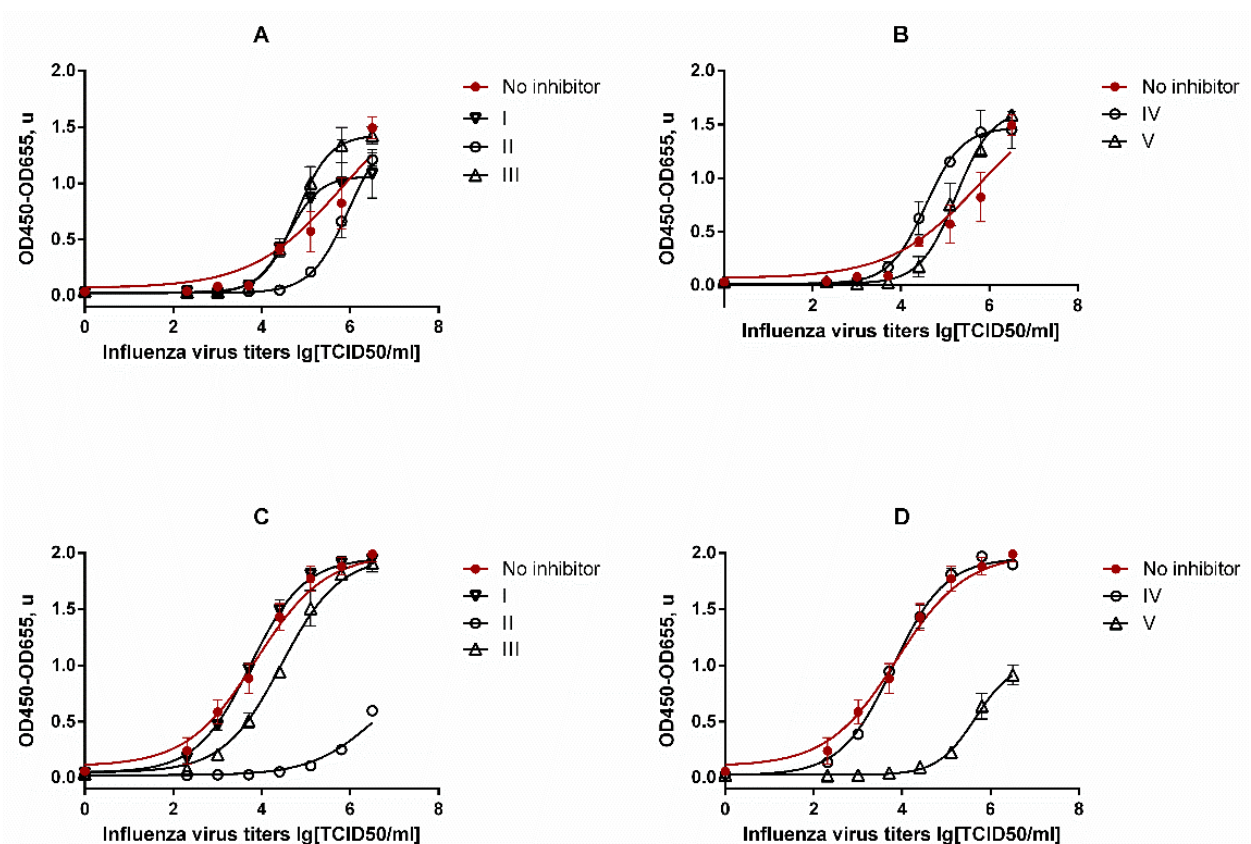
Figure 3. The assessment of the investigated compounds’ antiviral activity by ELISA. ( A , B ) the content of virions in supernatants obtained from cells upon stimulation with compounds II , III , and V ( A ) and IV , I ( B ). ( C , D ) The viral NP protein content inside the cell upon stimulation with II , III , and V ( C ) and IV , I ( D ) preparations. The ordinate scale (it is expressed in optical density units) is directly proportional to the content of the viral NP protein in the samples. The data obtained for HAV-infected cells which are not stimulated with substances are shown in red.